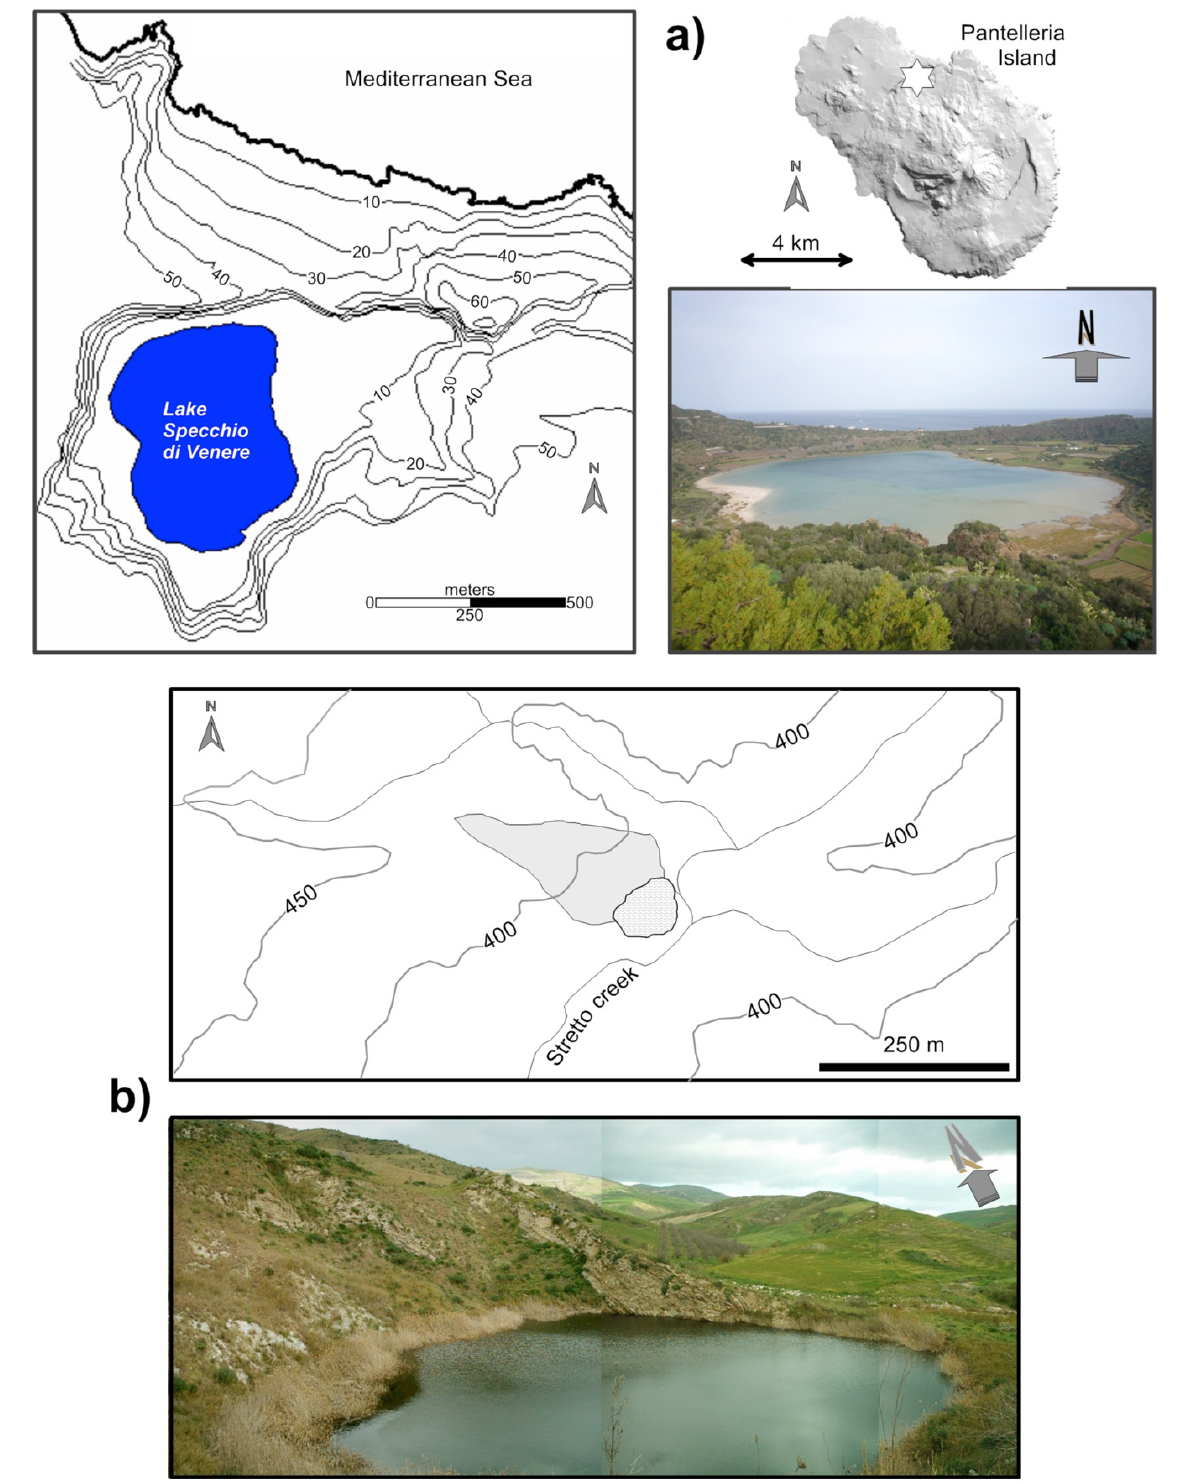
Figure 2. From top to bottom: a) DEM of Pantelleria Island showing the location of lake Specchio di Venere (white star), its elevation (m a.s.l.) contour map and a field photograph of the lake; b) elevation (m a.s.l.) contour map of lake Sfondato with indication of the stream network (light grey lines), surface catchment area of the lake (grey polygon) and lake contour (light grey polygon) and a field photograph of the